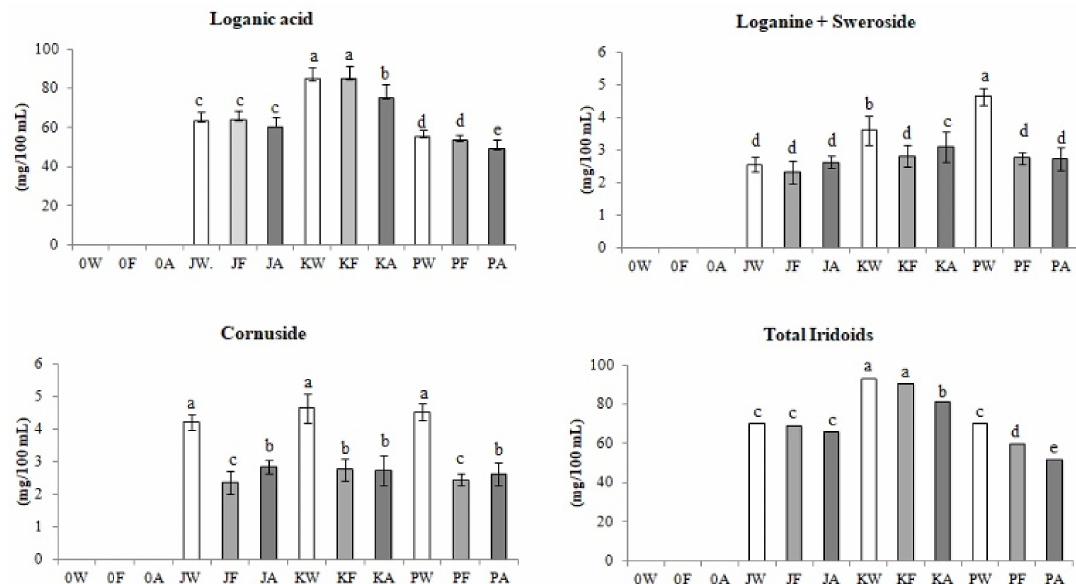
Figure 5. Changes in iridoids content (mg/100 mL) during control and fruit meads production technology. White bars— worts (W), light gray bars—samples after fermentation (F), dark gray bars—meads after aging (A). Sample codes: 0—control, J—samples with ‘Jantarnyi’ juice, K—samples with ‘Koralowyi’ juice, P—samples with ‘Podolski’ juice. Mean values with different letters: a, b, c, d, e are statistically different ( p <